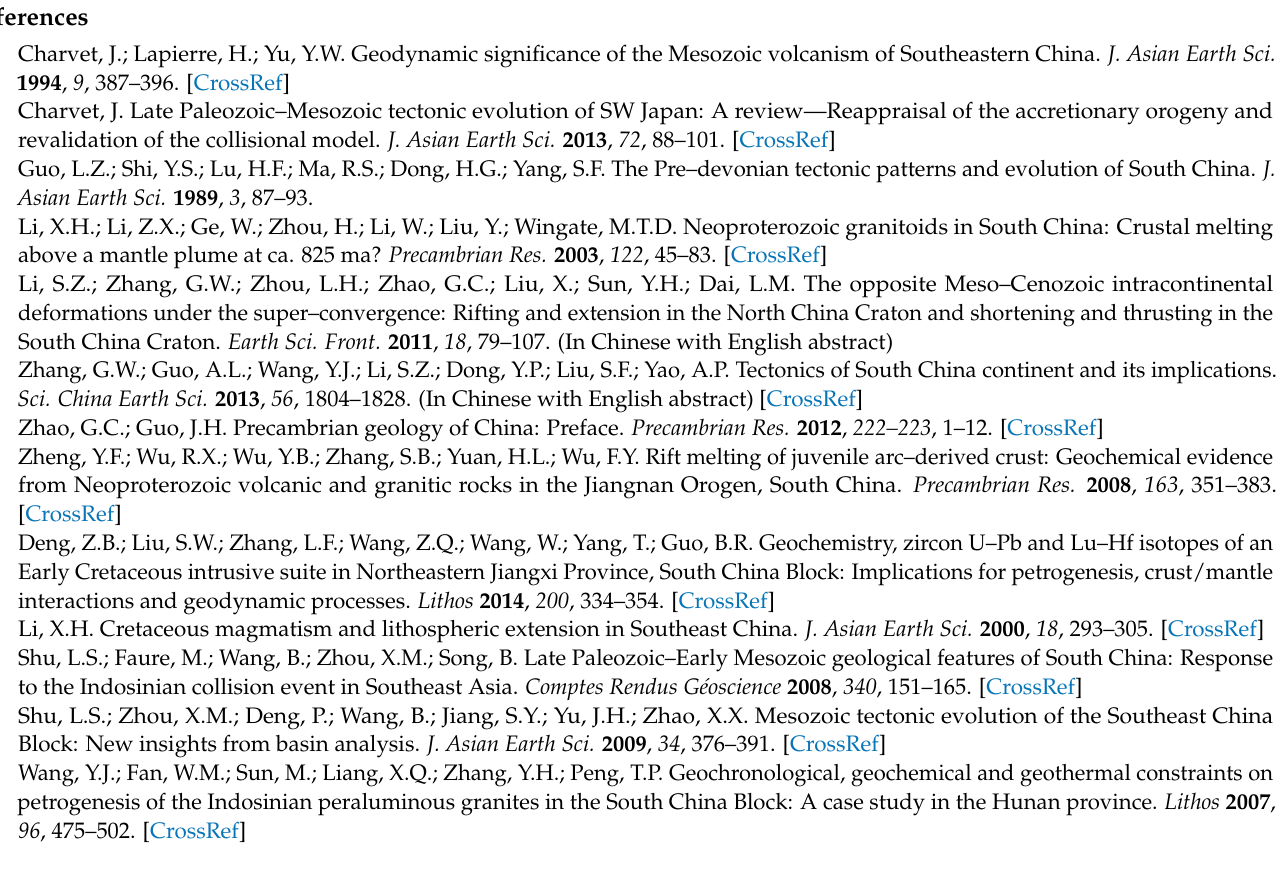
Table S4: Whole-rock trace–element (ppm) compositions of the Zhuxi granites (H285–H573) and granites. Table S6: Summary of U–Pb age data for Northeastern Jiangxi and adjacent